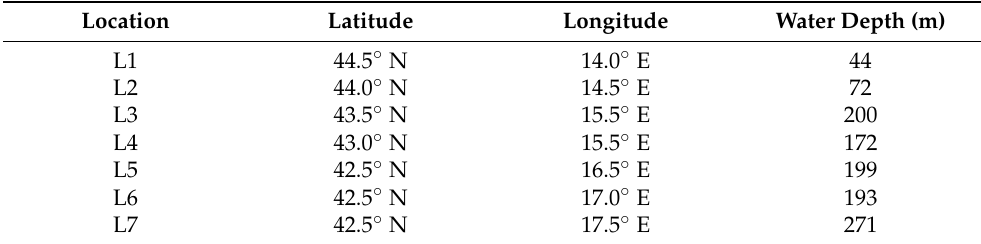
Figure 2. Seven locations along the Croatian coastline. Table 2. Geographical coordinates of the selected locations in the Adriatic Sea and water depth. Reproduced with permission from [21].